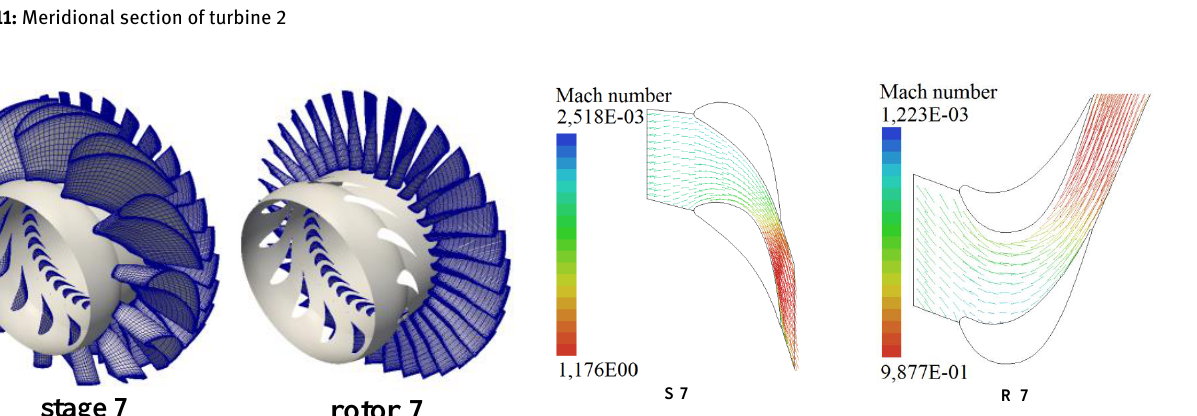
Figure 12. Hub-to-tip sections of stator and rotor blades for stages 5-7 and isometric view of stage 7